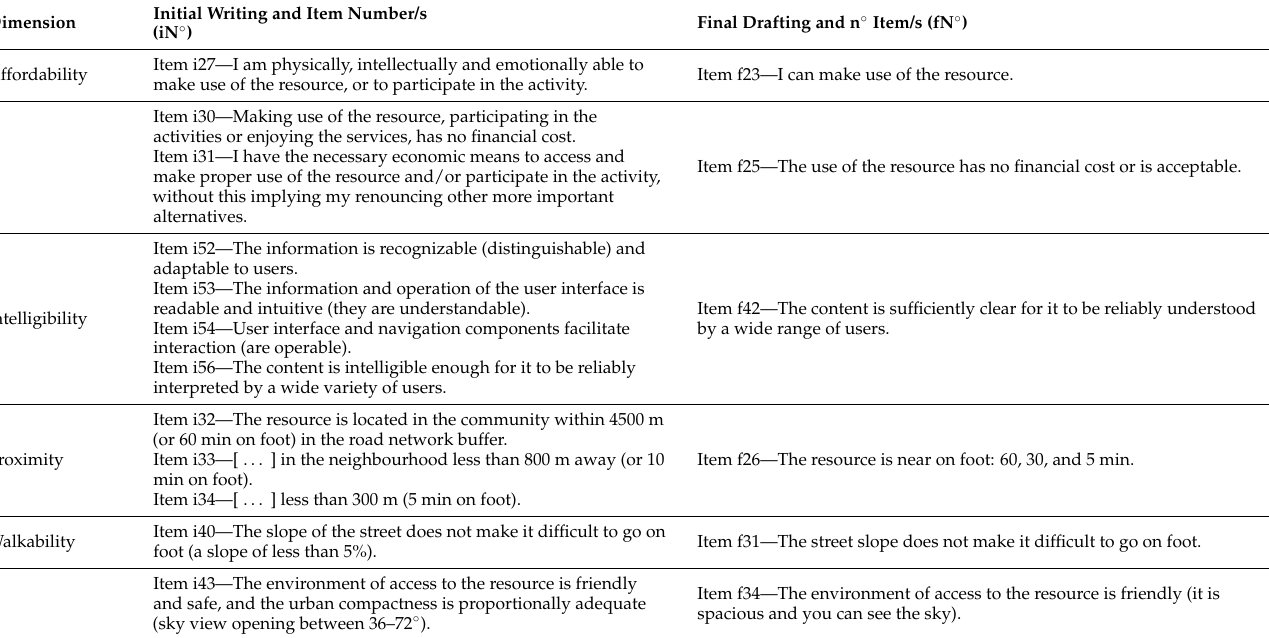
Table 5. Notable modifications of items of (perceived)